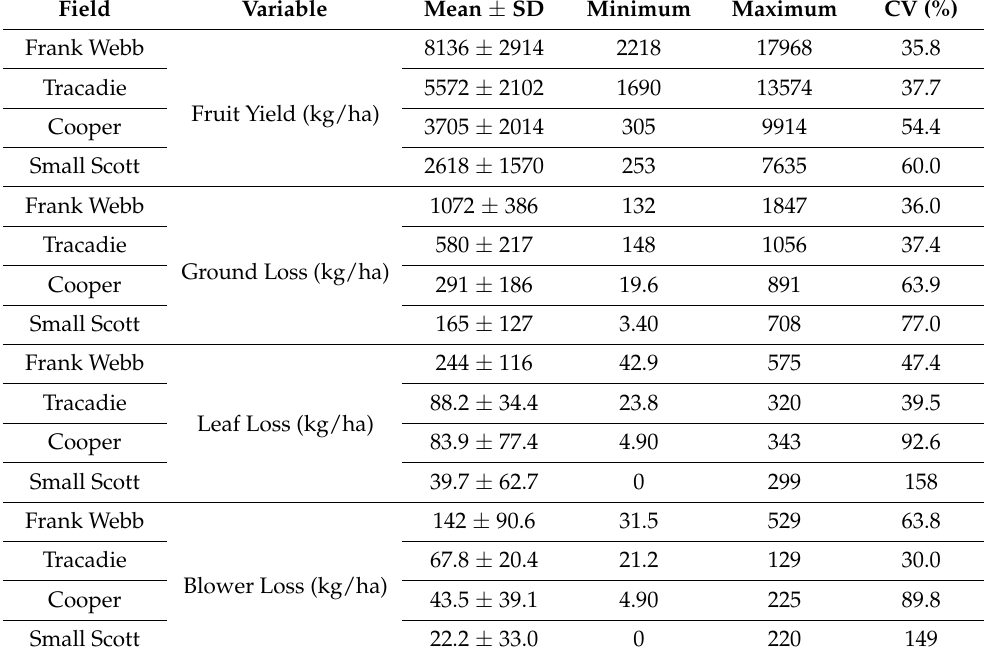
Table 3. Descriptive statistics of chosen